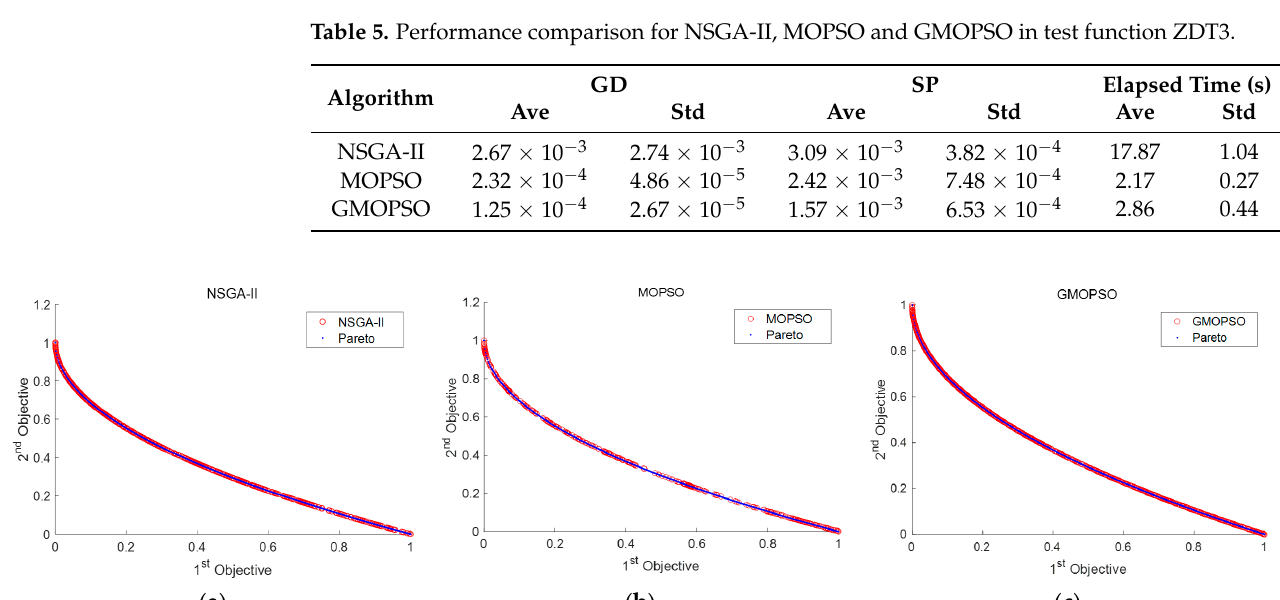
Figure 4. Test results of function ZDT1. ( a ) Pareto solutions of NSGA-II; ( b ) Pareto solutions of MOPSO; ( c ) Pareto solu- tions of GMOPSO.